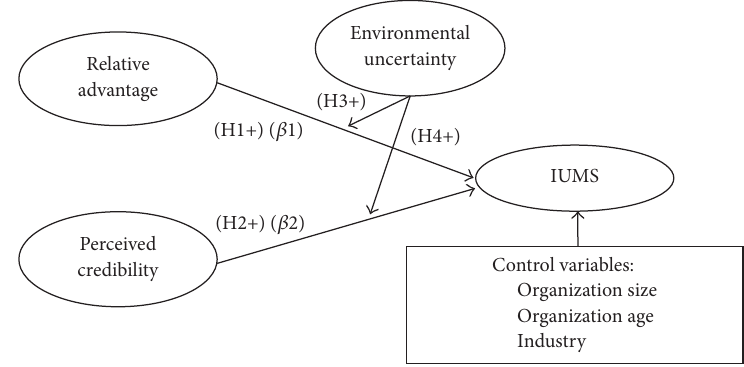
Figure 1: Research model.